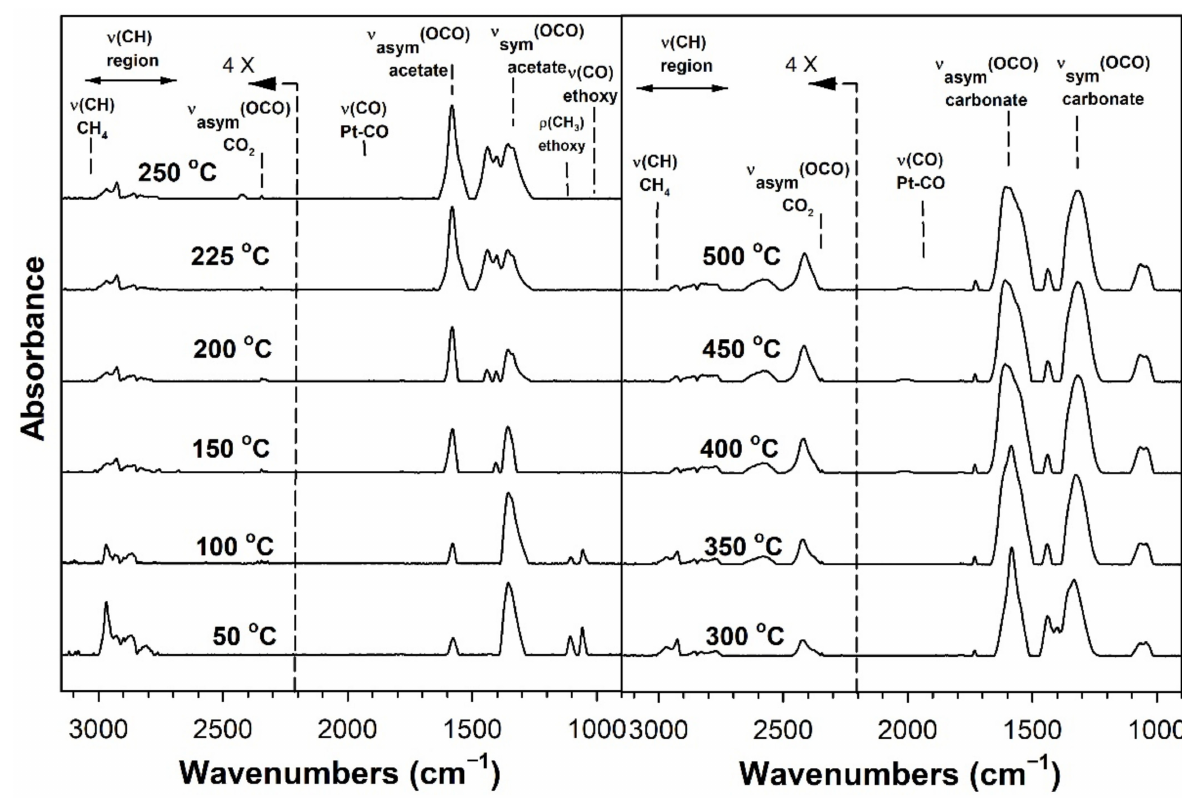
Figure 11. DRIFTS spectra of transient ESR over 9.29% Rb-2% Pt/m-ZrO 2